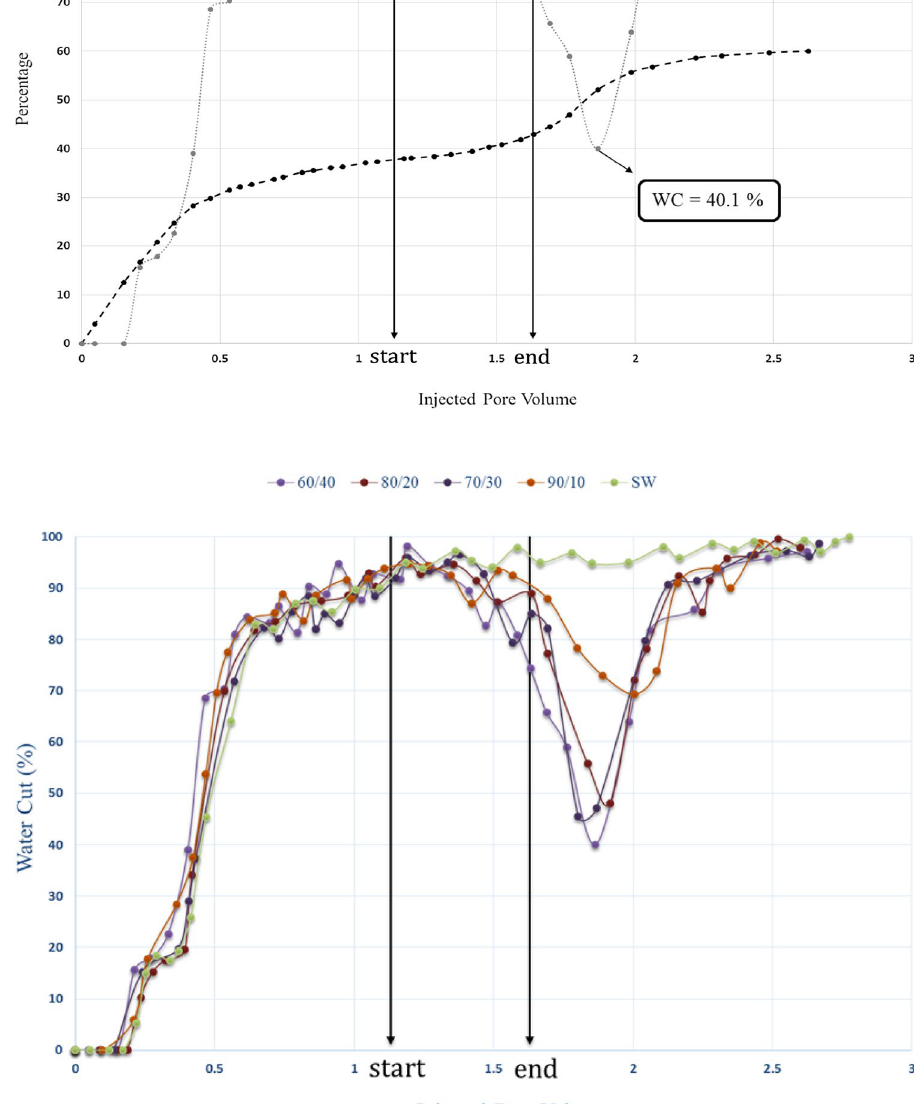
Fig. 8 Cumulative oil recovery and water cut during SW injec- tion and subsequent injection of emulsion 60/40 (test 5)